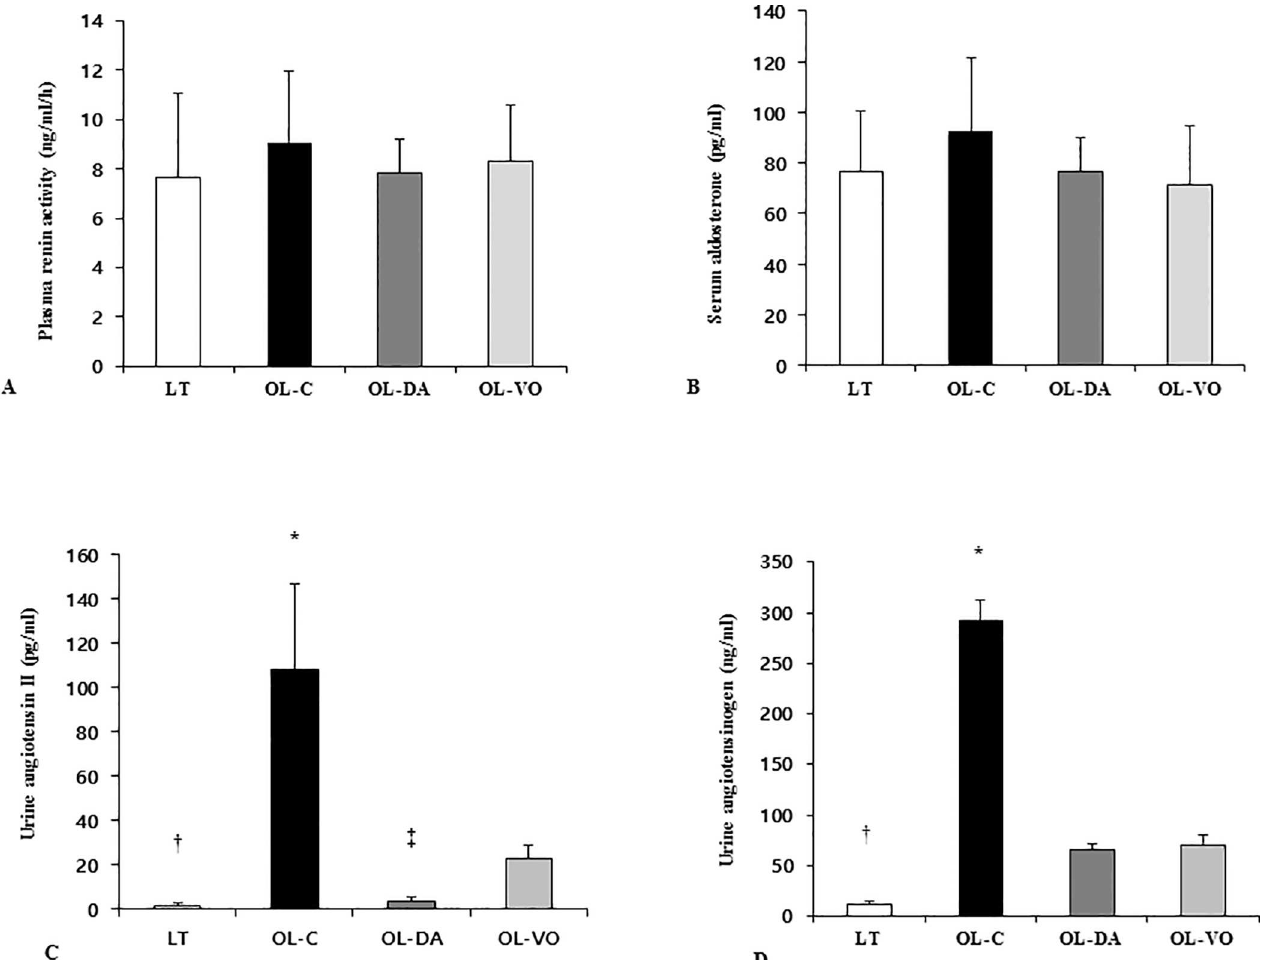
Fig 3. Systemic and intrarenal RAS activation at 12 weeks. Plasma renin activity (A), serum aldosterone(B), urinary angiotensinII (C) and angiotensinogen (D) in LETO (LT) and OLETF rats with saline (OL-C), dapagliflozin (OL-DA) or voglibose(OL-VO) treatment. * P < 0.05, OL-C vs. other groups; † P < 0.05, LT vs. other groups; ‡ P < 0.05, OL-DA vs. OL-VO. Values are expressedas means ±